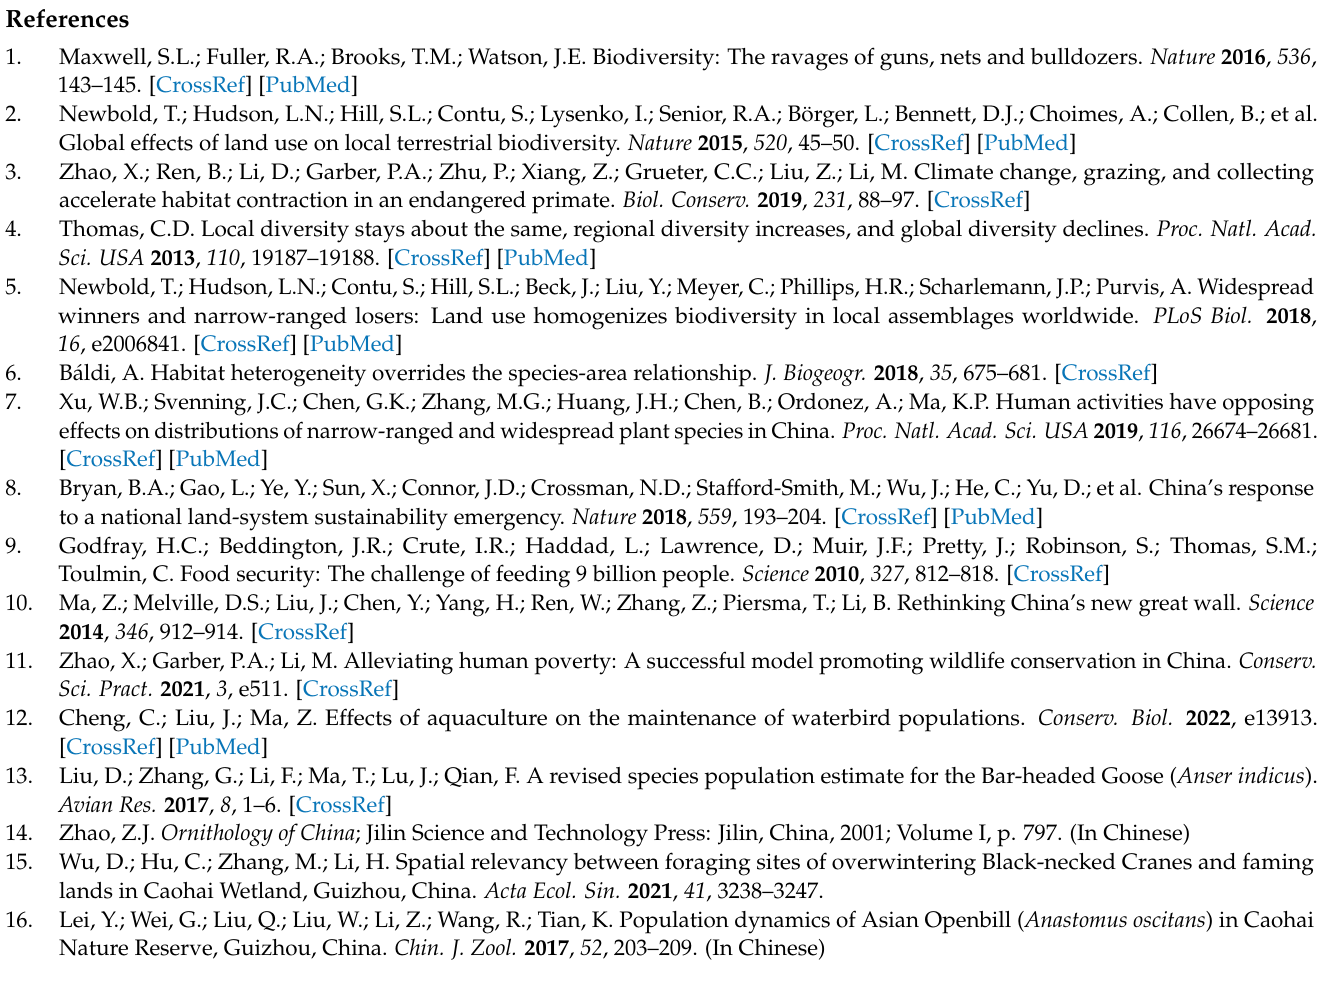
Table S3. Results of Model selection based on linear models. The top 10 models ranked by criterion corrected for small sample sizes (AICc). Predictive variables include Precipitation, Temperature, Open water, Wind velocity. NA indicates that the predictive variable is not included in the given